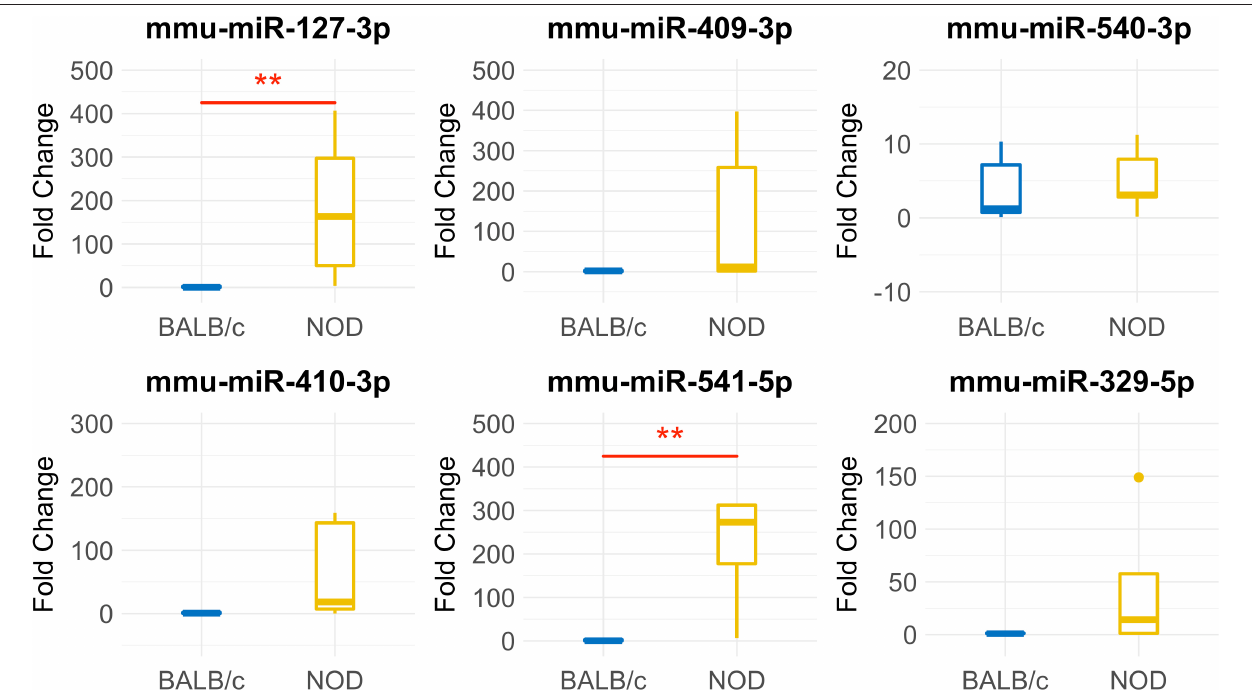
FIGURE 5 | Validation of miRNA ‘hits’ in Size Exclusion Chromatography (SEC)-purified serum exosomes from 14-week male BALB/c and NOD mice. Fold-change data represent mean ± SD normalized to miR-16-5p using the 11 Ct method. Statistical significance was determined by the Mann-Whitney U-test; ** p < 0.01. Results were obtained from data sets generated from qRT-PCR from RNA isolated from SEC-purified pooled serum exosomes from five groups of mice per strain, with 5 mice per group. All mice were age matched.